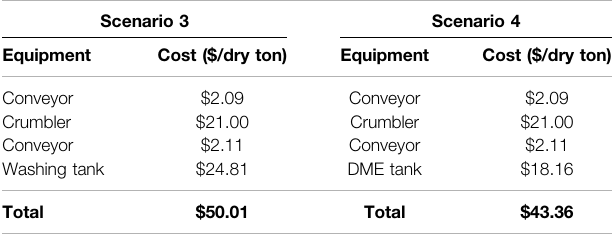
TABLE 4 | Breakdown of costs for size reduction without OCC (scenario 1) and with OCC (scenario 2) pre-processing unit operations. Scenario 1